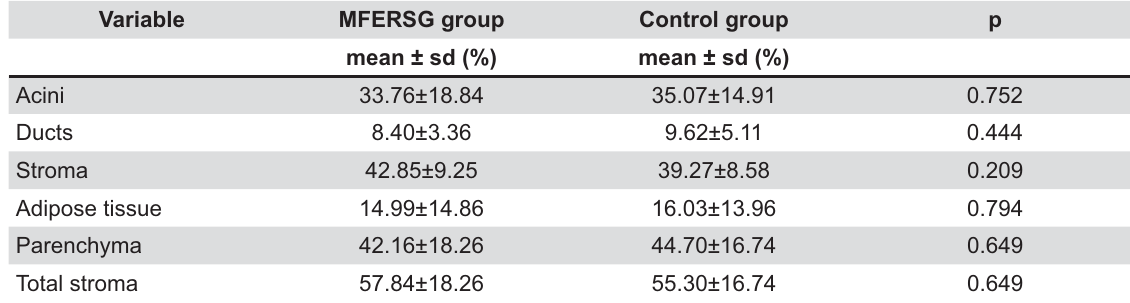
Table 2- Means and standard deviations (mean ± sd) of various volume densities in both